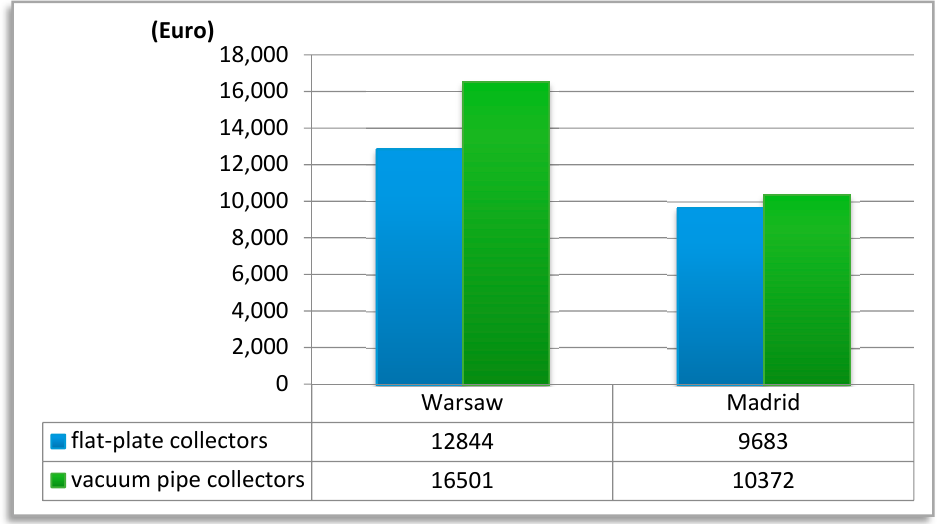
Figure 2. Investment outlays for heating and DHW installations in Poland and Spain (based on [8]).